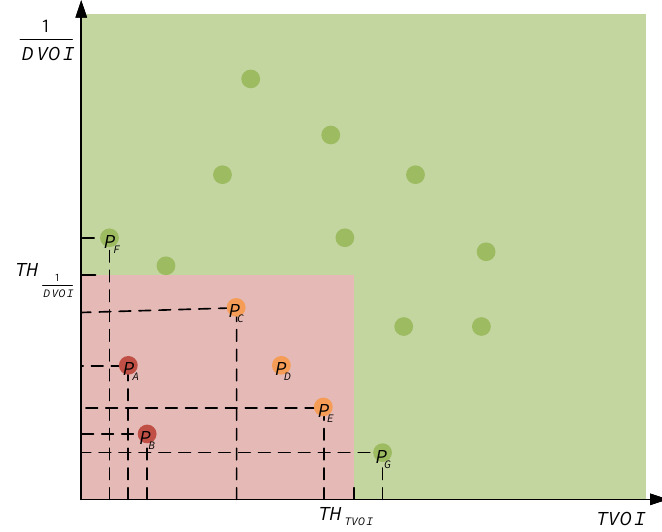
Figure 9. Diagram of the Pareto selection algorithm with a threshold. Algorithm 2. Algorithm for obtaining the Pareto frontier with a threshold. Algorithm 2: Get Pareto Frontier